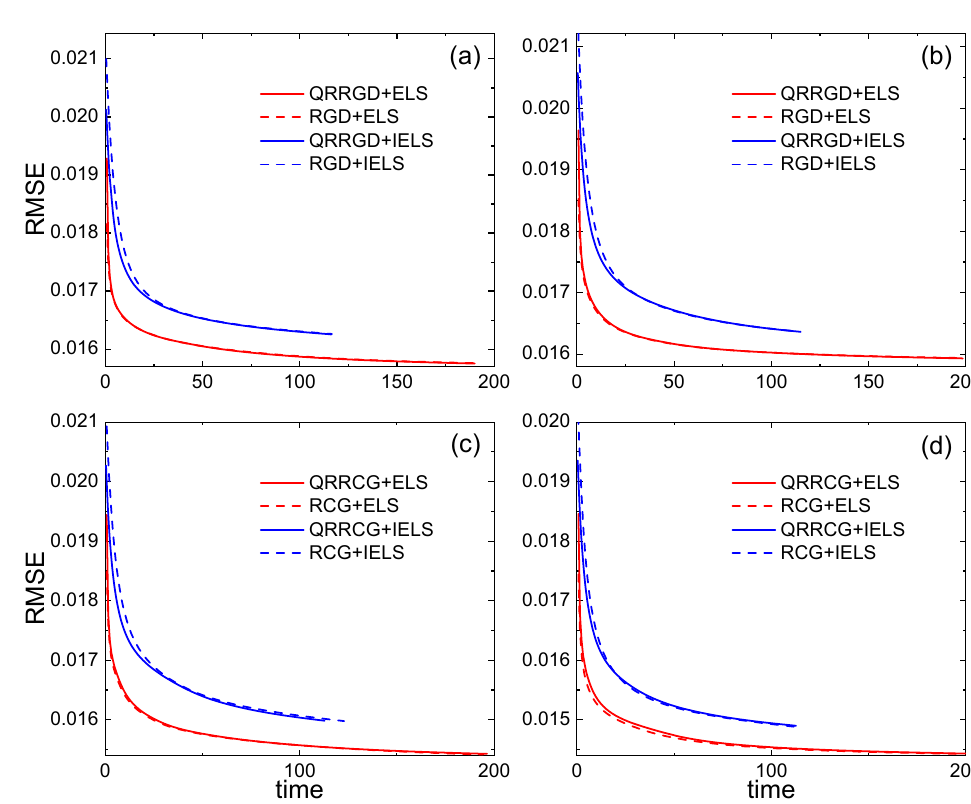
Figure 6. Performance comparison of RGD ( a , b ) and RCG ( c , d ) with and without QR factorization. Simulations were carried out on the same matrices M built by PeMS Traffic. We applied ELS and IELS to find the step size. The parameter values are n 1 = 173, n 2 = 6837, p = 0.05, r = 3, and OSF =